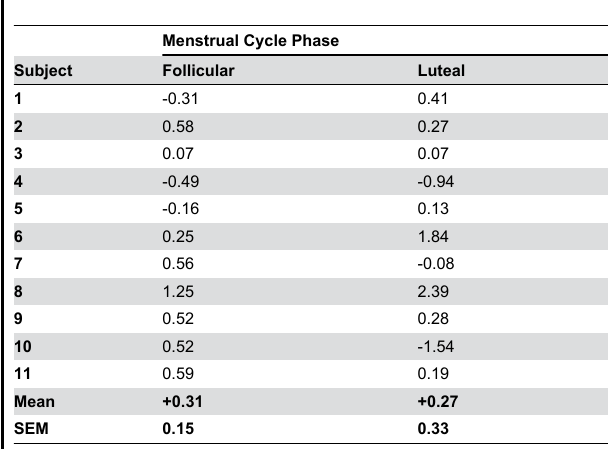
Table 3. Difference in EndoPAT index from baseline post orthostasis for individual female subjects on the OCP